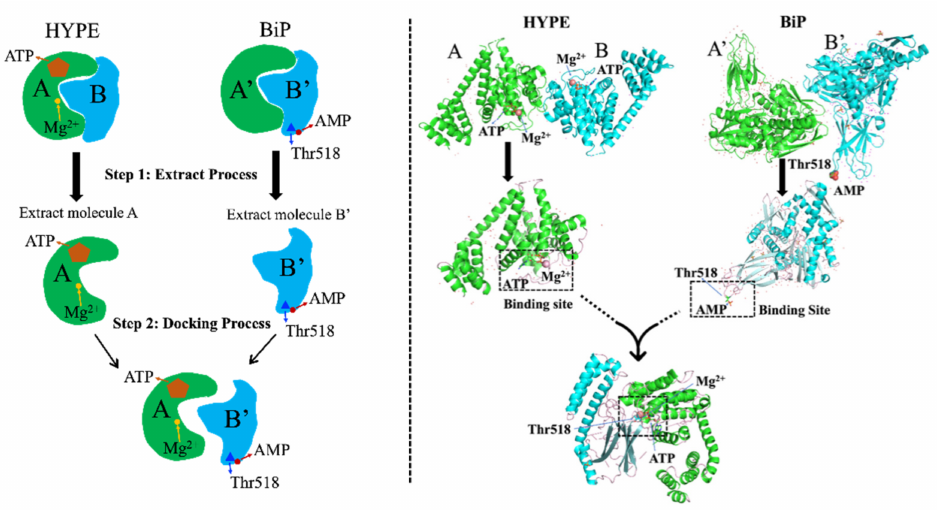
Figure 6. An illustration of Model building using HYPE protein and the substrate BiP protein. Schematic diagram ( left column ) and Protein structures ( right column